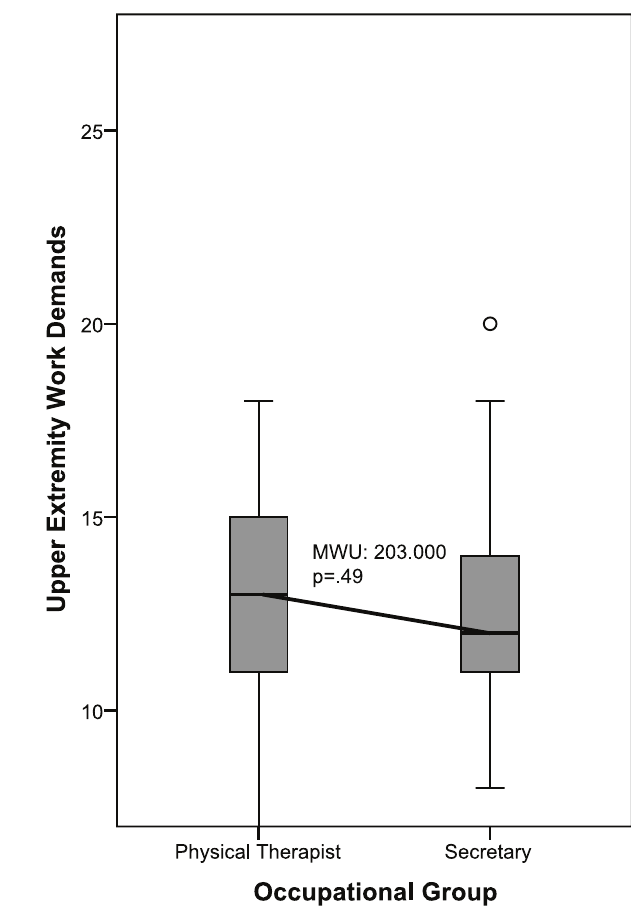
DOT-categories. MWU Mann Whitney U test; Scoring range of the Upper Extremity Work Demands: 7–28.